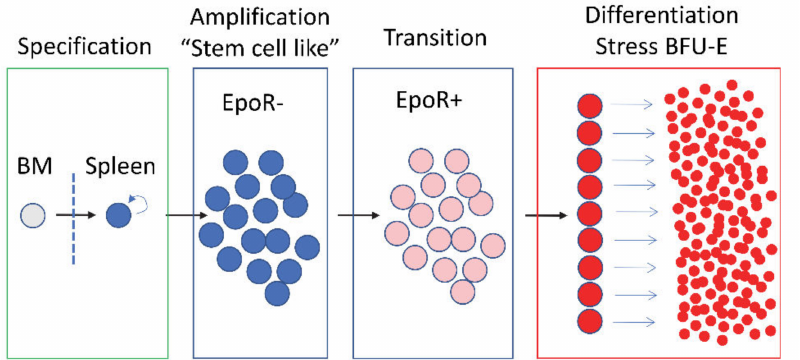
Figure 1. Schematic of stress erythropoiesis. Stress erythropoiesis proceeds through four stages. BM—bone marrow, EpoR—erythropoietin receptor, BFU-E—Burst forming units